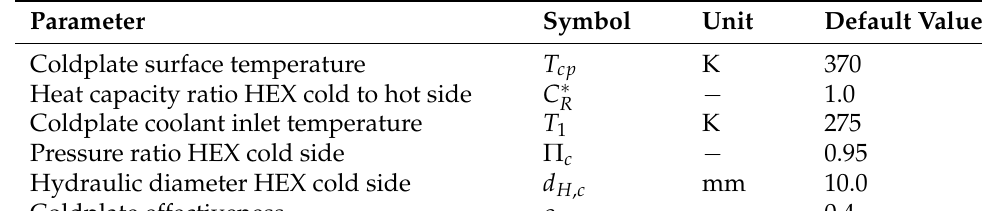
Figure 6. Design and off-design (HDTO) heat loads for S P = 30% for one powertrain. Table 2. Parameters considered in the one-dimensional sensitivity analysis.